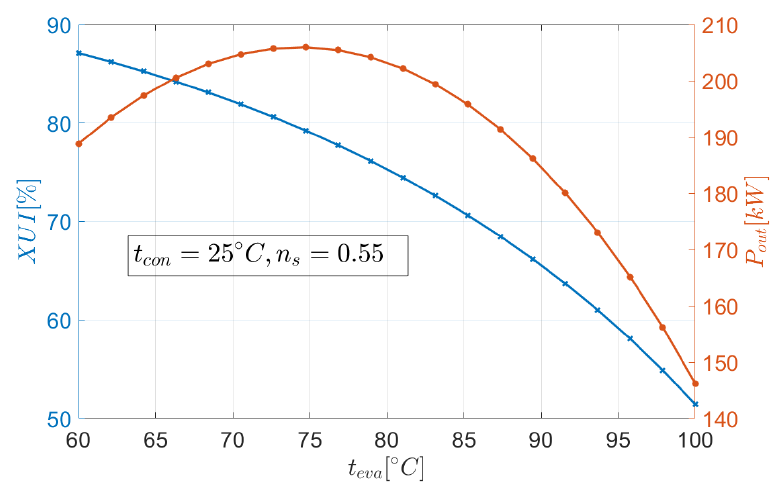
Figure 5. XUI and net power output P out as functions of evaporation temperature t eva .